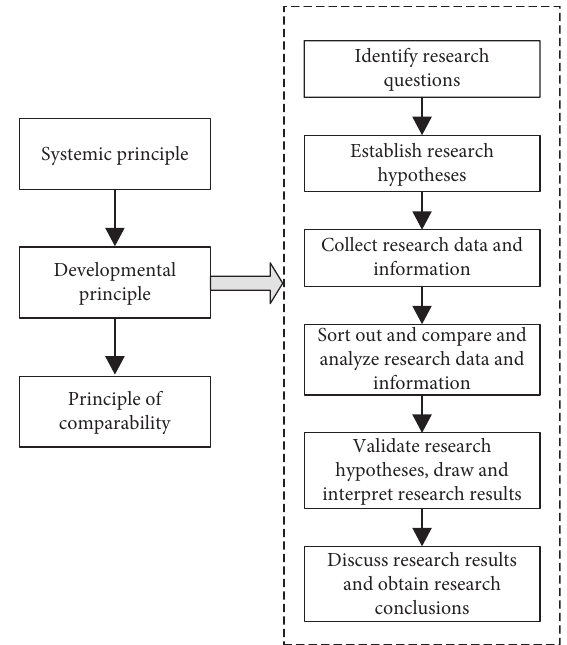
Figure 1: Comparative education research method